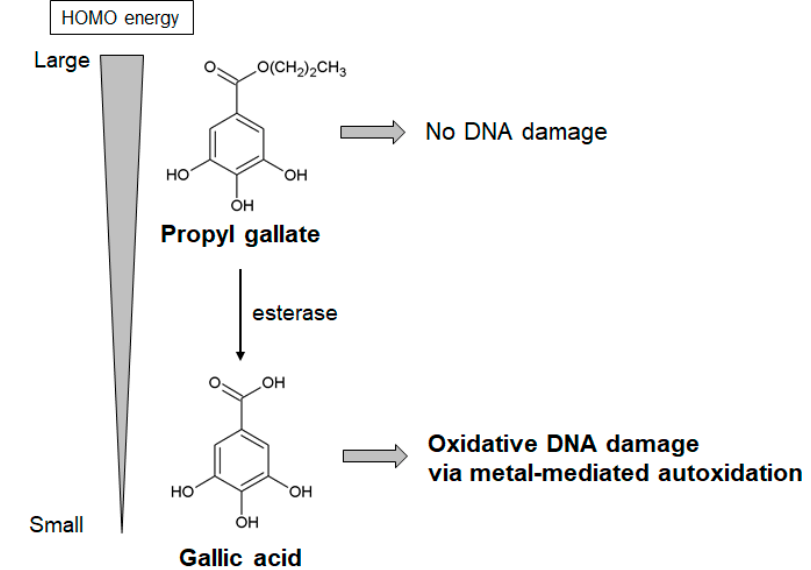
Figure 6. Estimation of HOMO energy to assess the pro-oxidant reactivity of gallic acid and propyl gallate. HOMO energies of gallic acid and propyl gallate were estimated from ab initio molecular orbital calculations at Hartree–Fock 6-31G* level. Calculations were performed using Spartan 02 for Windows (Wavefunction Inc., CA) [125]. HOMO energy: highest occupied molecular orbital energy